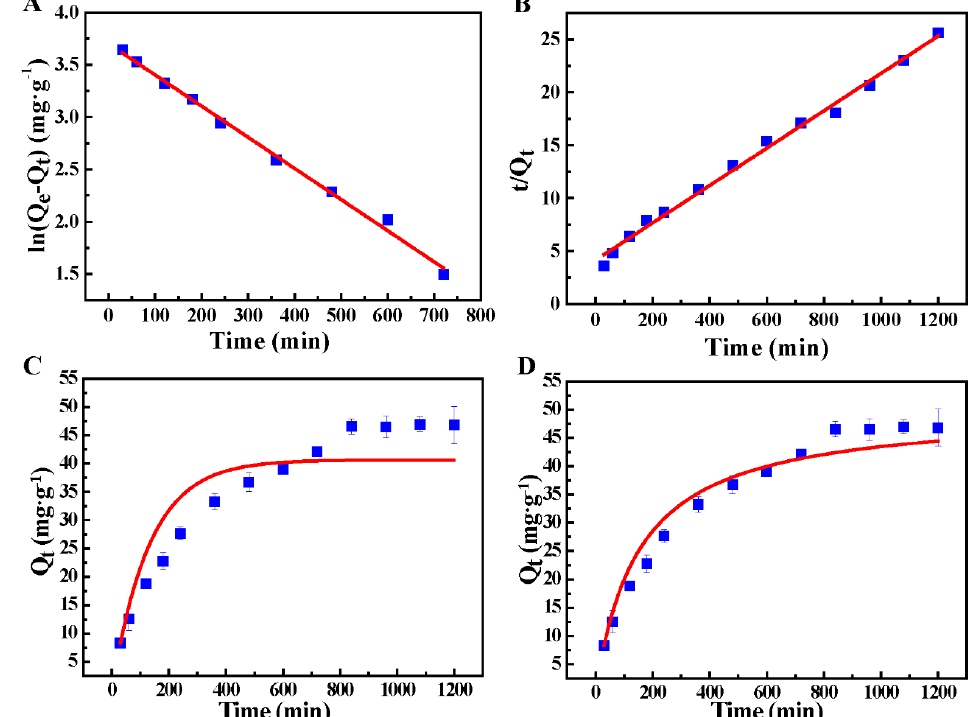
Figure 5. ( A , C ) Linear and nonlinear fitting plots of pseudo-first order kinetic models; ( B , D ) linear and nonlinear fitting plots of pseudo-second order kinetic models. Table 3. Pseudo-first order kinetics and pseudo-second dynamics simulation parameters of Pb 2 + . in HHTB.